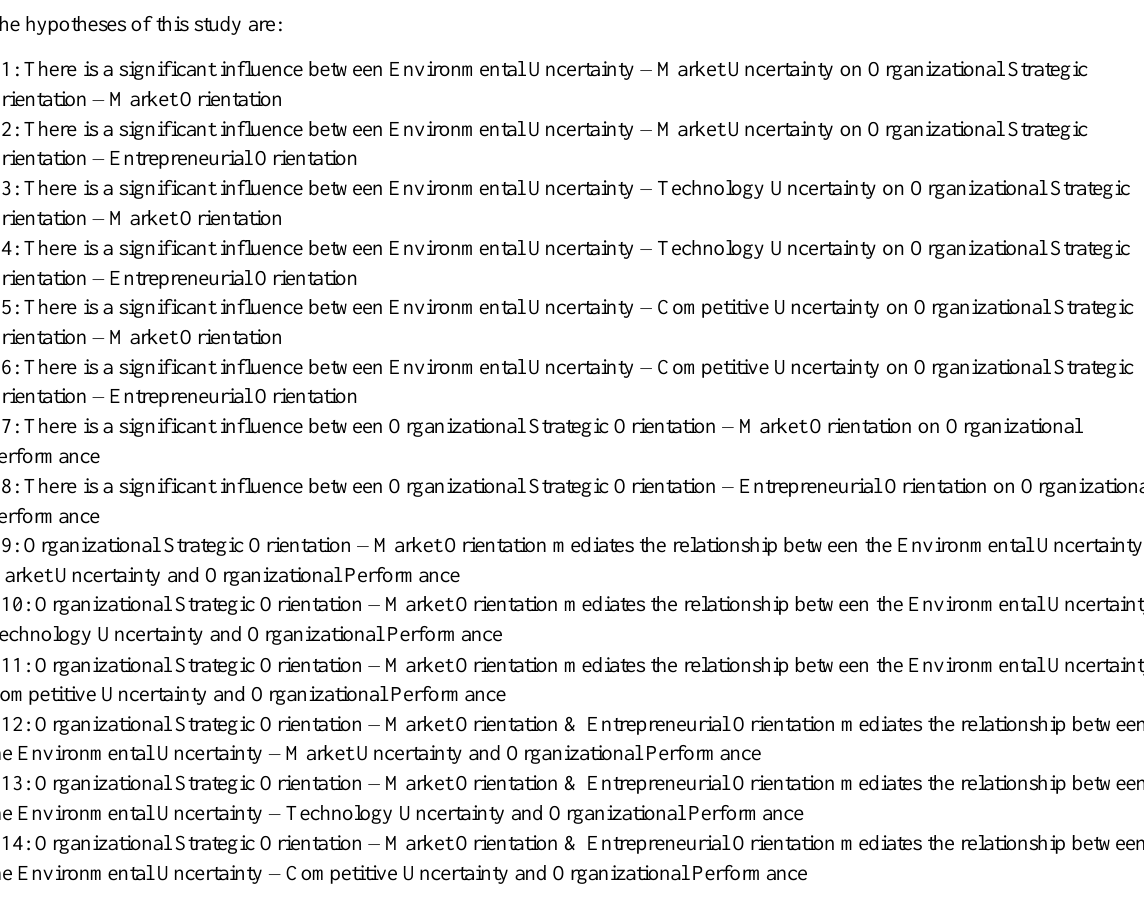
Figure 1: Research Framework &